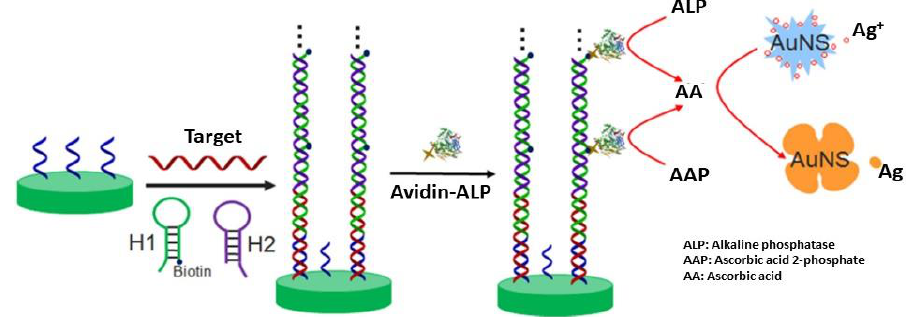
Figure 26. DNA detection by naked-eye readout with the silver reduction on gold nanostars [188].